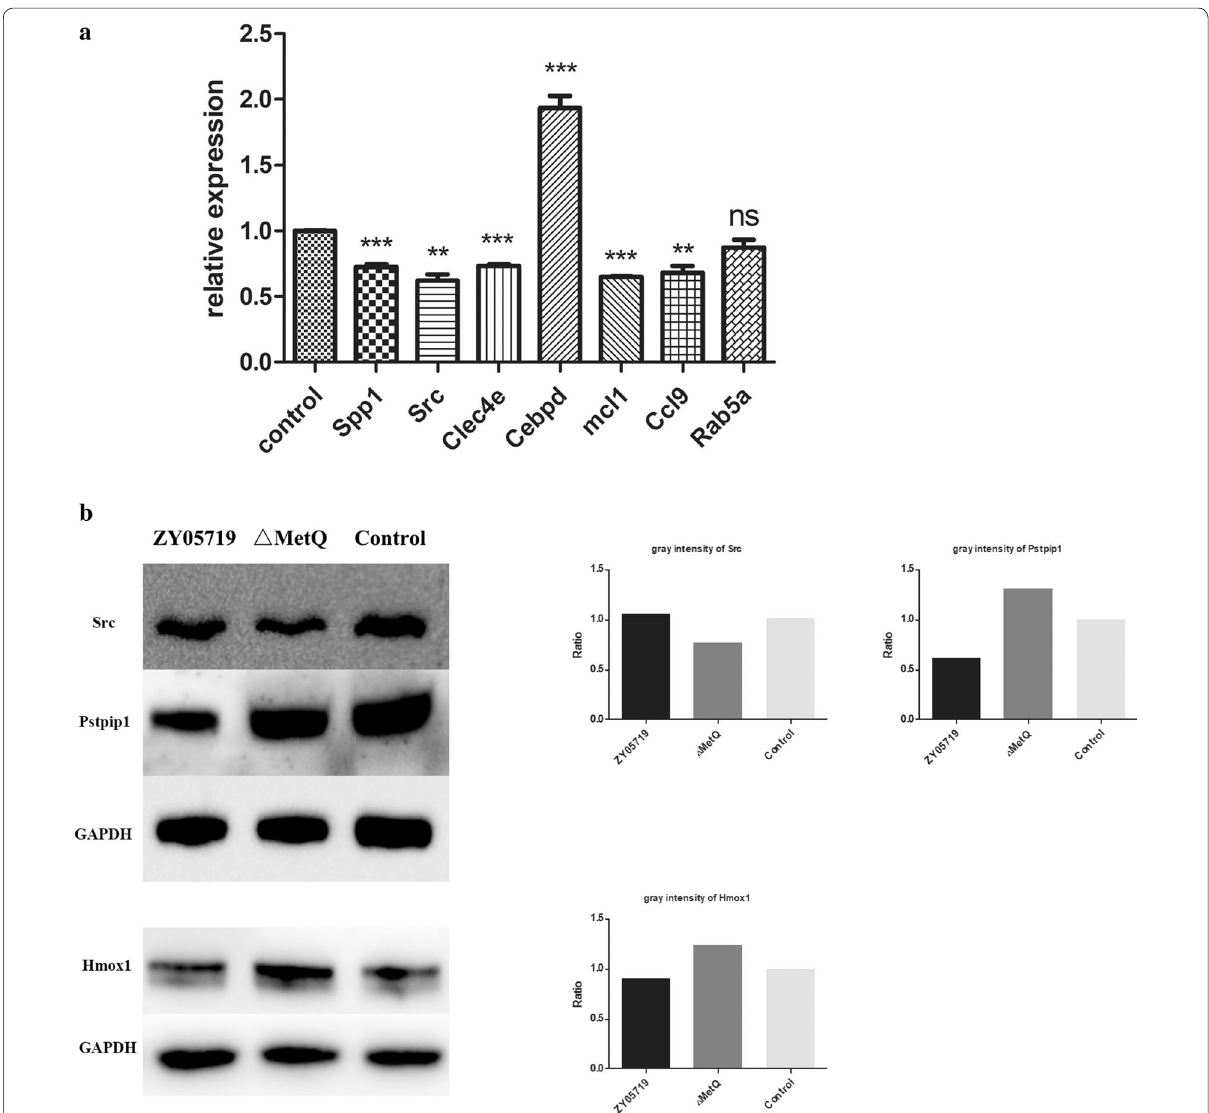
Fig. 5 Validation of proteomics results. a Seven genes encoding for the corresponding differentially expressed proteins were selected to verify the proteomics results by qPCR. The results were calculated by 2 − △△ CT method. b Pstpip1, Src and Hmox1 proteins were selected for the validation of the quantitative proteomics. GAPDH was used as reference. The gray intensities are shown on the right. ZY05719, ZY05719 treated cells; △ MetQ , △ MetQ treated cells; control, non-infected cells. The statistical significance was determined by Student’s t test. * p < 0.05; ** p < 0.01; *** p <